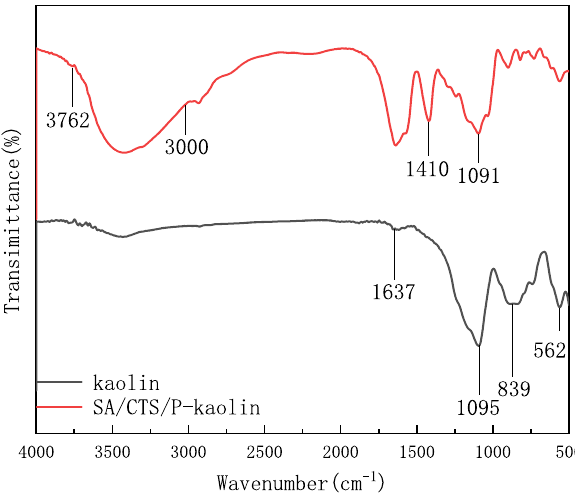
Figure 1: FTIR spectra of kaolin and the SA/CTS/P - kaolin composite